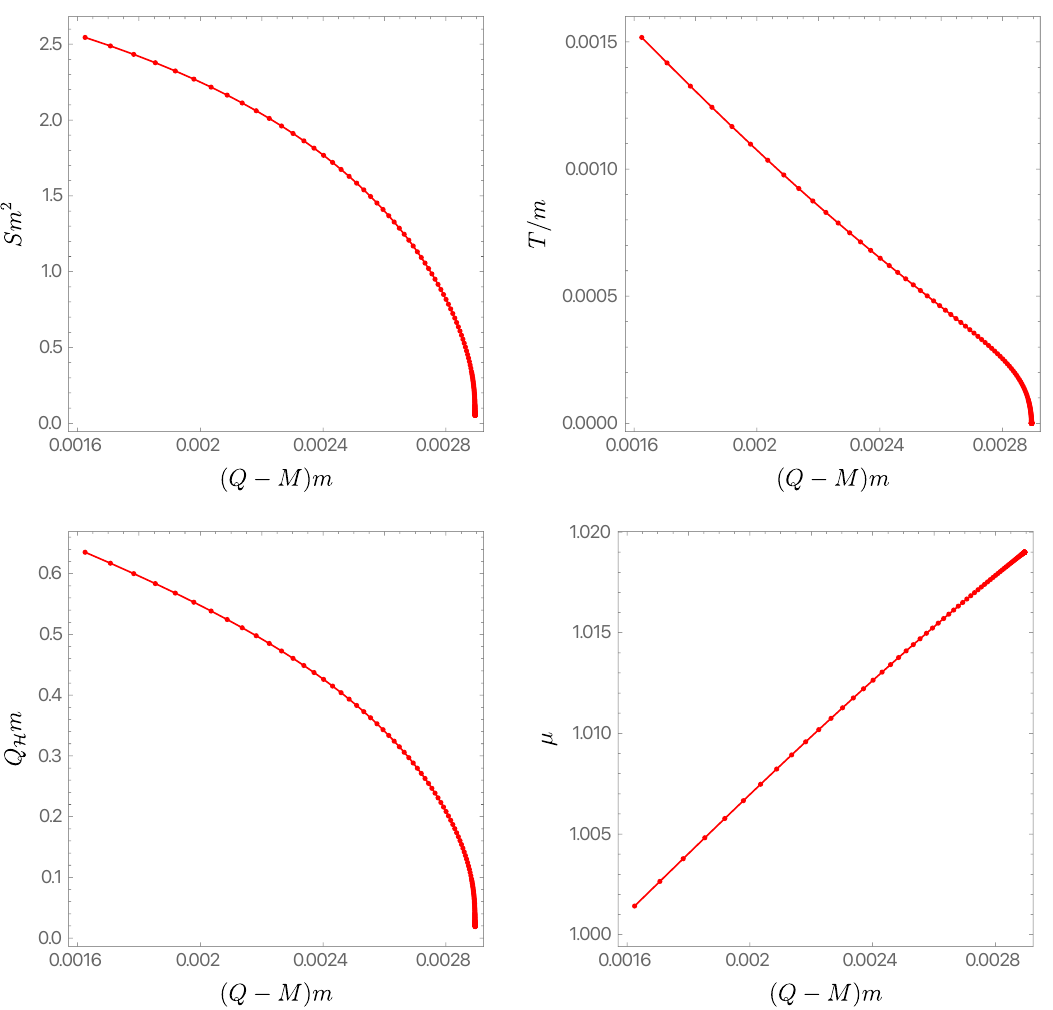
Figure 6 . Physical properties of black holes approaching extremality, with q = m/ 2 , α = 1 , and Mm = 1 . This is a representative example of q/m . 0 . 99 solutions where the maximum charge hairy black holes always approach a singular extremal